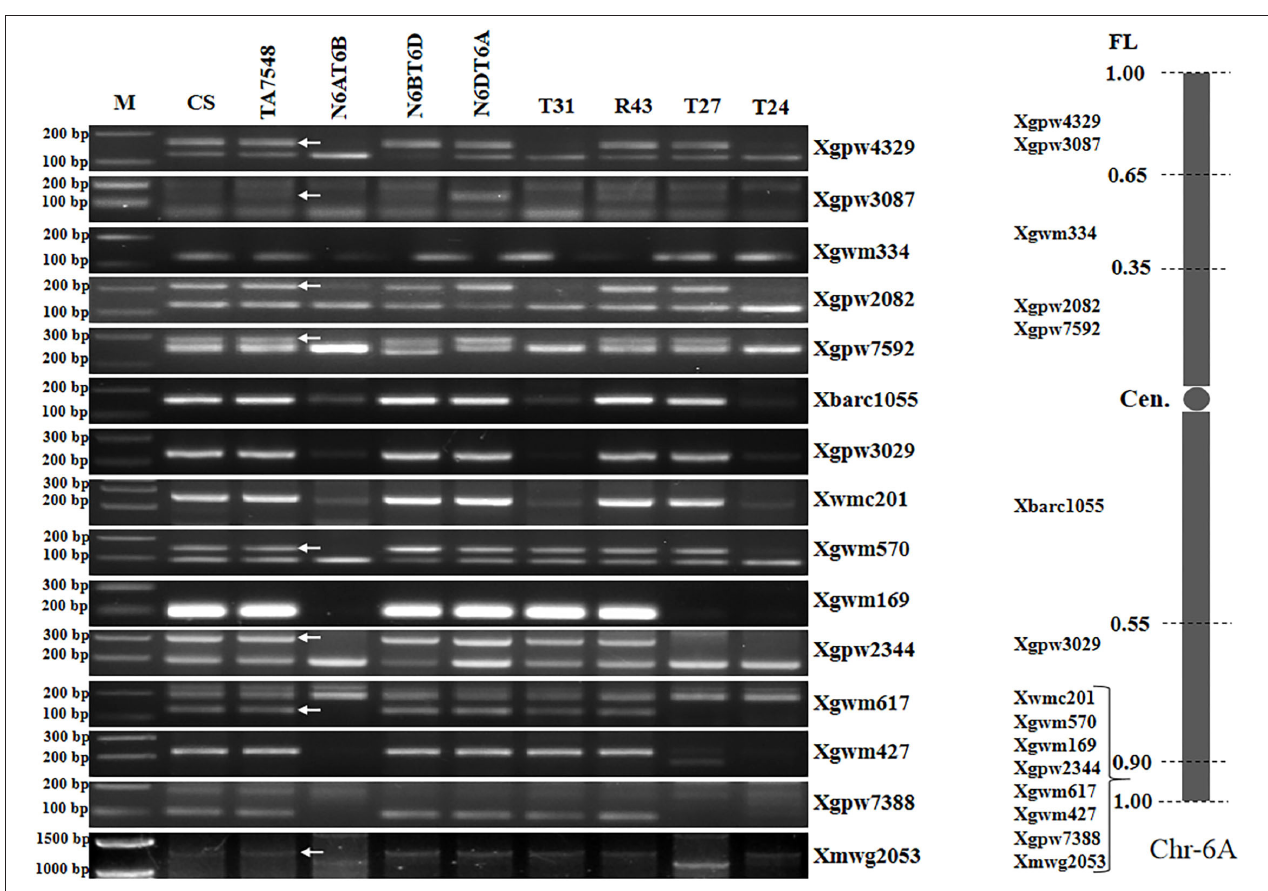
FIGURE 5 | Molecular markers analysis of 6S l #3 recombinants using wheat 6A SSR markers. Arrows pointed to 6A-specific bands when two or more bands were amplified using a single primer pair. M: 100 bp DNA ladder